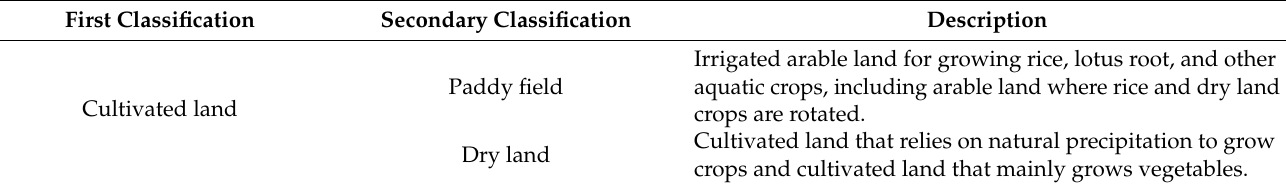
Table A1. Description of landscape classification in Zhongmu